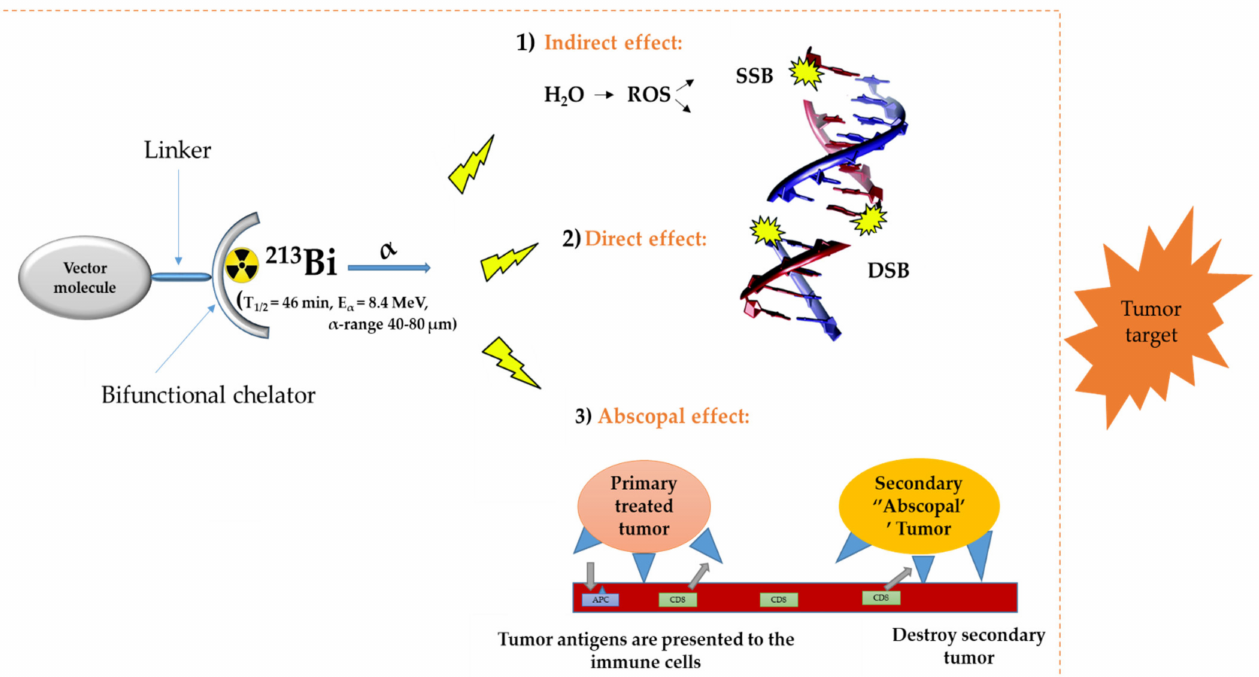
Figure 1. General concept of TRNT. ROS = reactive oxygen species, SSB = single strand break, DSB = double strand break, APC = antigen presenting cells, CD6 = cluster of differentiation 6. The DNA structure was reproduced from Gill and Vallis 2019, with permission from the Royal Society of Chemistry [9], Royal Society of Chemistry,